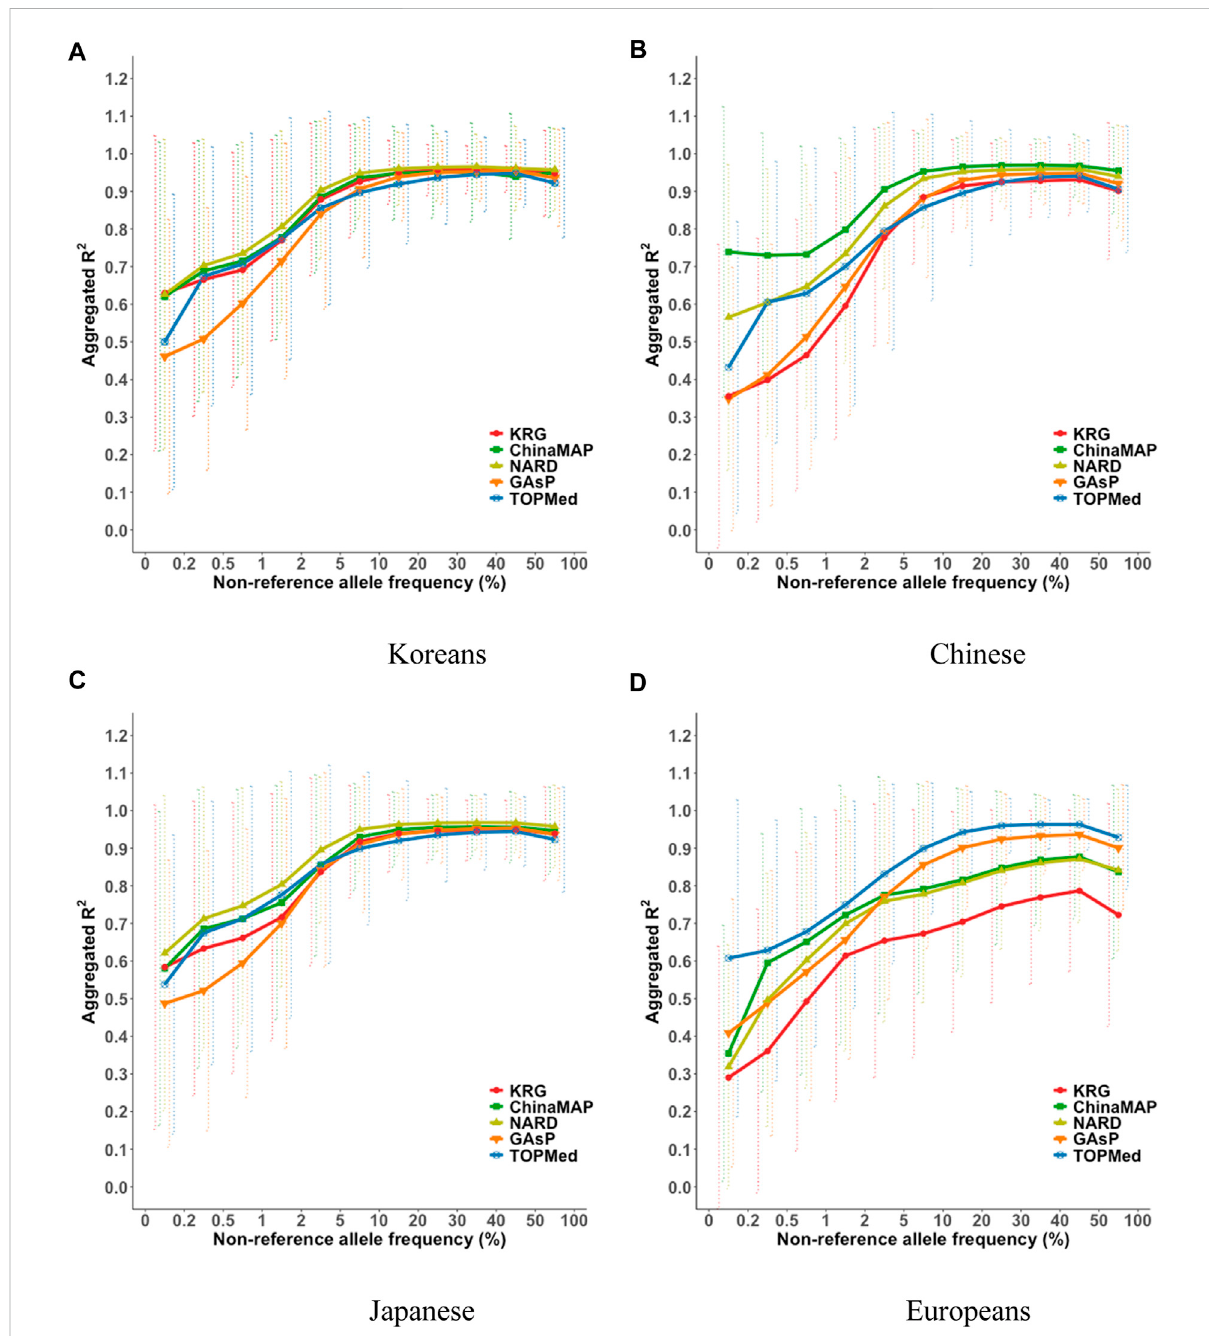
FIGURE 3 AggregatedR 2 basedoncombiningreferenceandgenotypepanelsmimickingtheKBA.Theaggregated R 2 valueswerecomputedforthetarget sampleof (A) Korean, (B) Chinese, (C) Japanese,and (D) Europeanpopulations.The x -axesindicatethenon-referenceallelefrequencies.The y -axes represent the aggregated R 2 of the imputation results. Vertical dashed lines indicate standard deviations of aggregated R 2 for each bin.